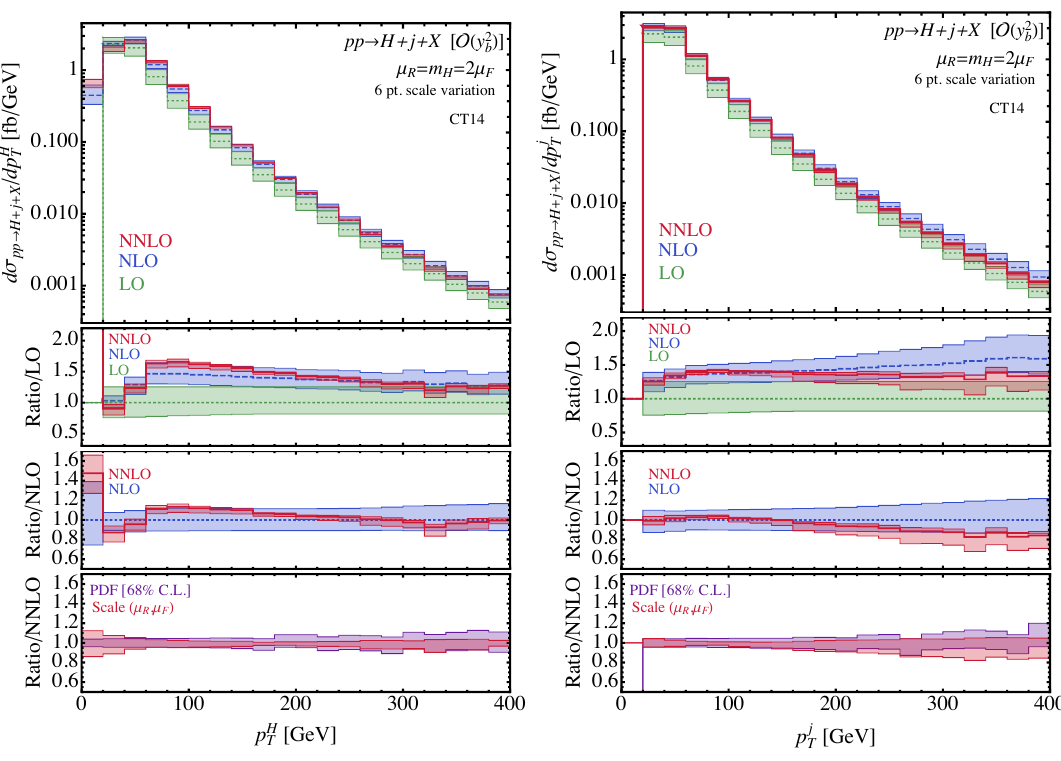
Figure 9 . Distributions of the transverse momentum of the Higgs boson ( p H jet ( p j , right) at LO, NLO, and NNLO accuracy. The top panel shows the distribution, while the T lower panels present ratios to the LO, NLO, and NNLO central predictions. In addition to the six-point scale variation, the lower panel presents estimates of PDF uncertainties at 68% C.L. (the other panels only include the scale